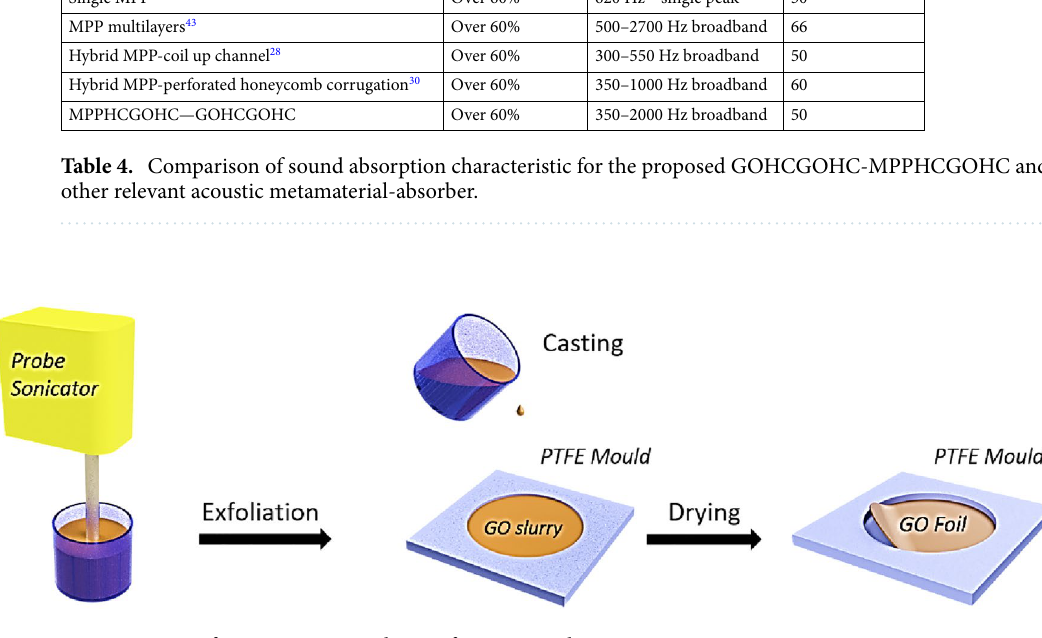
Figure 6. Manufacturing process scheme of GO